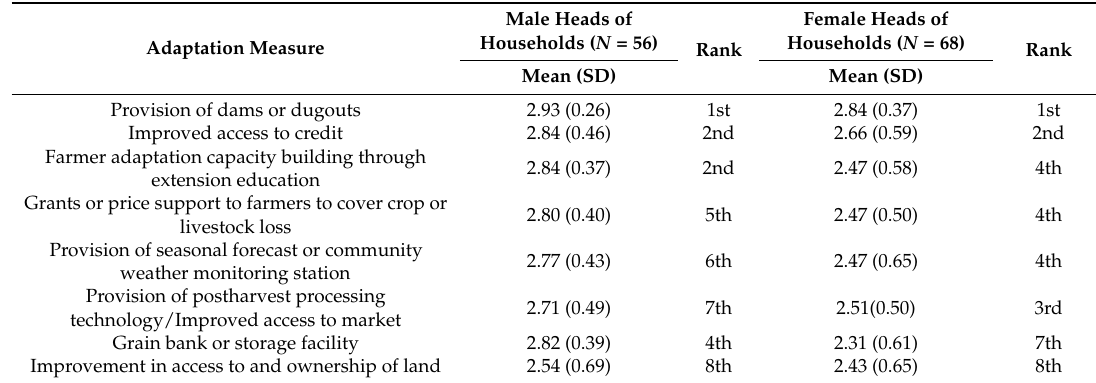
Table 4. Gender differences in preferred institutional support for adaptation.